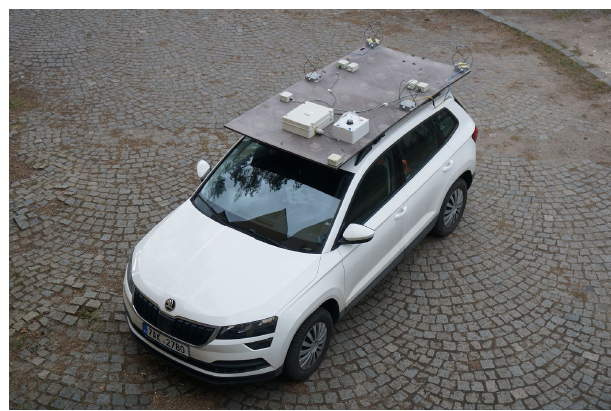
Figure 1. The CAR0 measuring car with the instruments mounted on the roof platform.